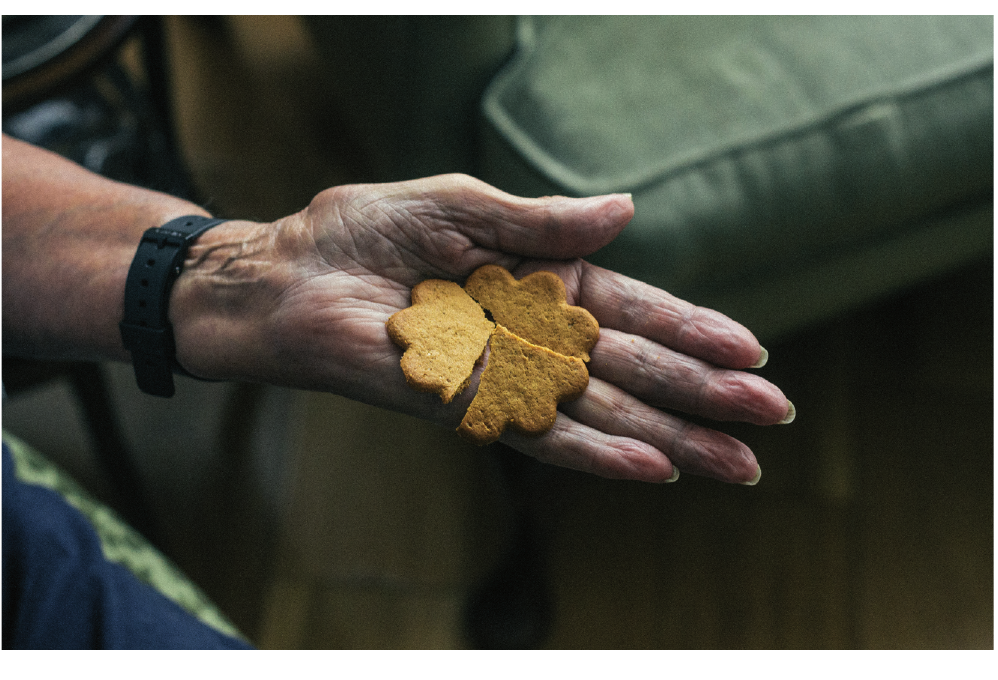
Credit: Halszka Staniewicz, 2015